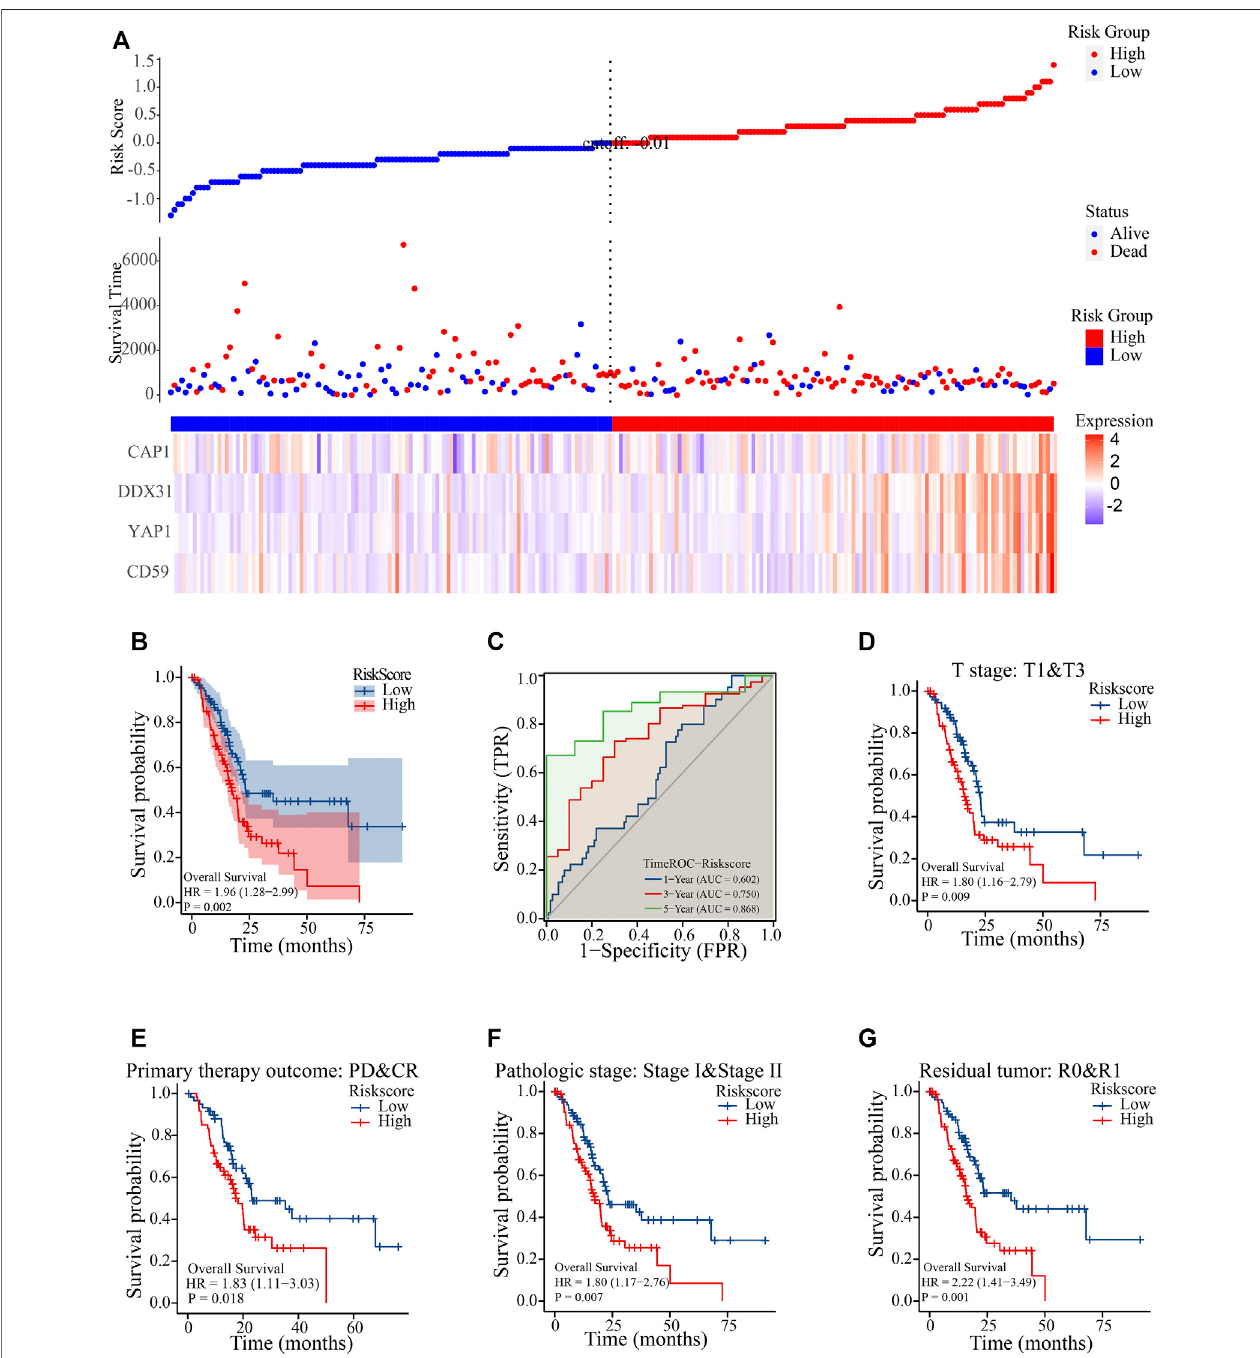
FIGURE 3 | Construction of the risk model. (A) : Constructing the risk prediction model with prognostic genes. Red represents the high-risk group, and blue represents the low-risk group. The risk model diagram contains three parts: risk value, patient ’ s survival state and expression level of risk factors. The expression heat map of risk factors is below, and the risk score curve is above. (B) : Survival K – M curve analysis of high- and low-risk groups. Red represents high-risk group, and blue represents low-risk group. p value less than 0.05 is considered to be statistically signi fi cant, and HR > 1 has the signi fi cance of promoting risk; HR < 1 has the signi fi cance of inhibiting risk. (C) : Time-dependent ROC curve of risk scores in prediction analysis of 1-, 3-, and 5-year survival time. The ordinate represents the sensitivity, The horizontal coordinate represents the 1-specitivity; the blue curve indicates 1-survival time, the red curve indicates 3-survival time, the green curve indicates 5-survival time; (D – G) : Survival K – M analysis of patients in high- and low-risk groups in subgroups of clinical stages (D) , pathological grade (E) , tumor recurrence (F) , and primary treatment prognosis (G) . P value less than .05 is considered to be statistically signi fi cant, and HR > 1 has the signi fi cance of promoting risk; HR < 1 has the signi fi cance of inhibiting risk. the blue curve indicates low-risk score, the red curve indicates high-risk score.